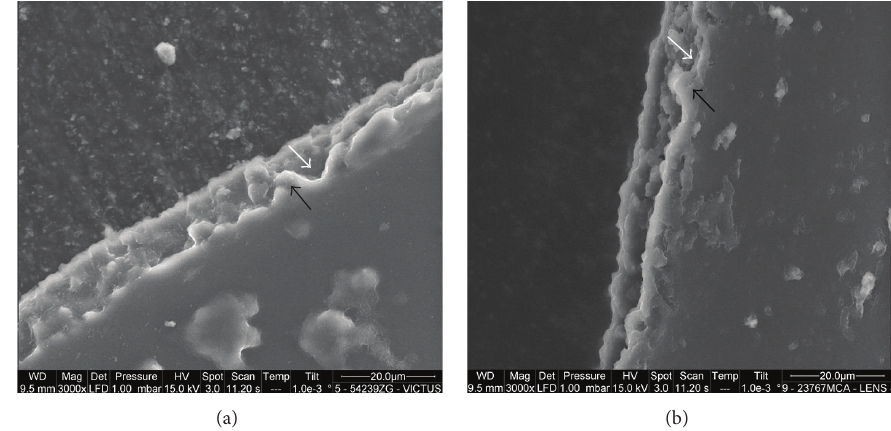
Figure 2: (a), (b) The Victus and LenSx capsulotomy cutting edges are shown, respectively. The microirregularities at the capsular edge are a direct consequence of the FS laser photodisruptive effects. Bumps (black arrows) and notches (white arrows) were spread across the cutting edges, giving rise to a variable pattern, ranging from a can opener to a postage stamp-like structure, that are consistent with cavitation and thermal effects of FS laser on the capsule